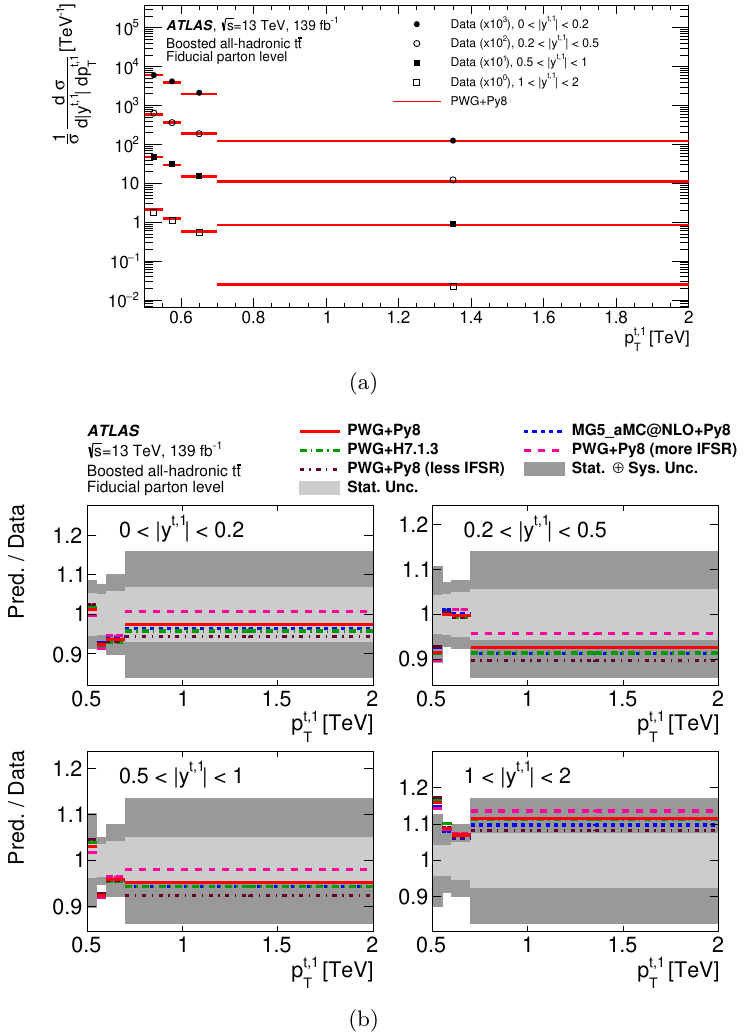
(a) Normalized parton-level fiducial phase-space double-differential cross-sections as a function of the absolute value of the leading top-quark rapidity and p T , compared with the Powheg+Pythia 8 calculation. Data points are placed at the centre of each bin and the Powheg+Pythia 8 calculation is indicated by solid lines. The measurement and the prediction are normalized by the factors shown in parentheses to aid visibility. (b) The ratios of various MC calculations to the normalized parton-level fiducial phase-space differential cross-sections. The dark and light grey bands indicate the total uncertainty and the statistical uncertainty, respectively, of the data in each